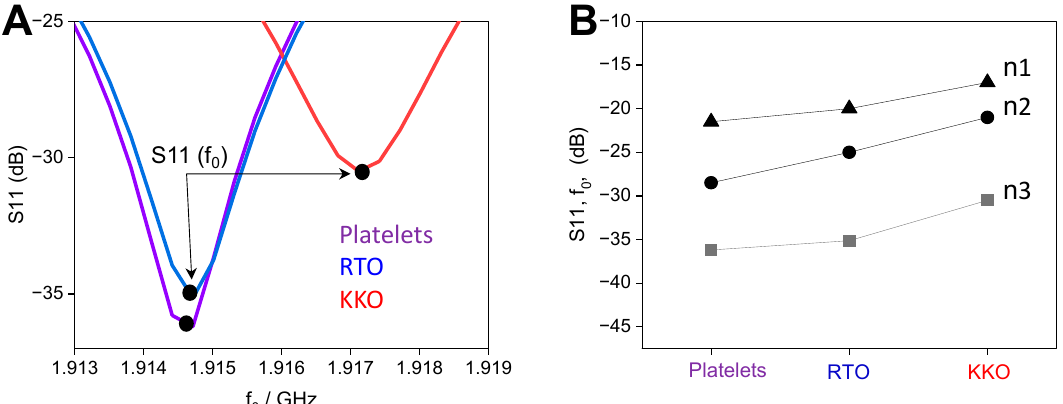
Figure 2. Visualization of platelet aggregation by confocal microscopy. No or very small aggregates and only minor change in platelet morphologies were seen in ( A ) platelet alone and ( B ) RTO, which can be considered as the background, but ( C ) KKO strongly caused platelet aggregates (arrows). The scale bar is the same for all images.